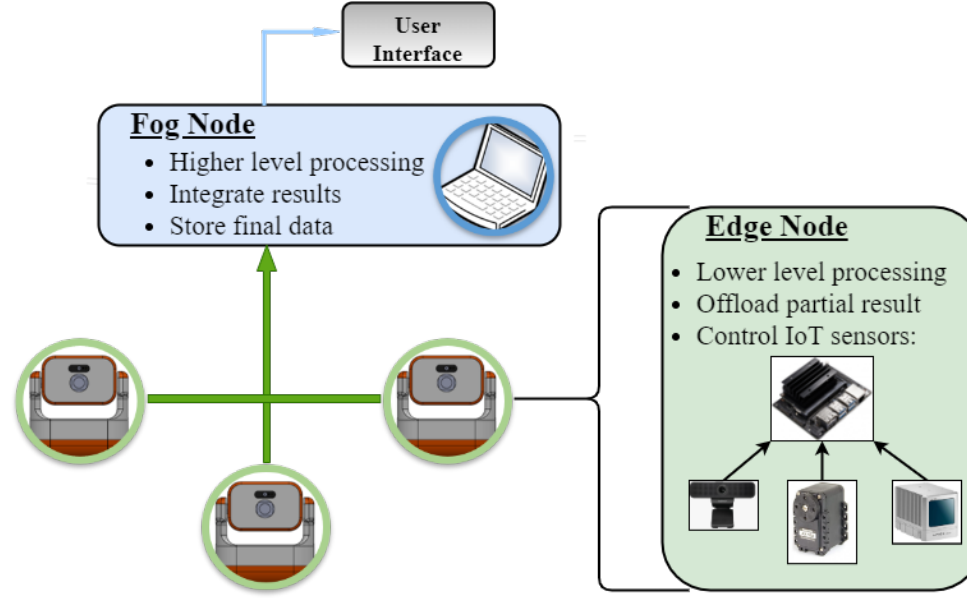
Figure 3. Edge-fog architecture illustration, with a summary of each node’s part in the architecture.